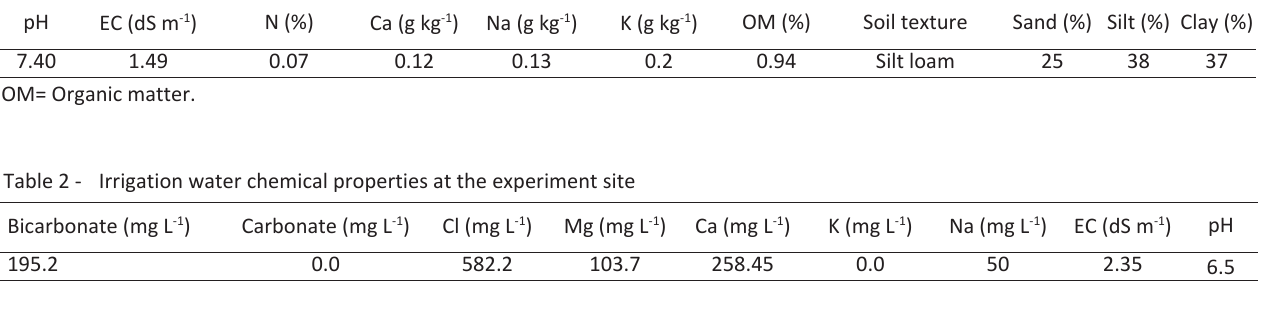
Table 1 - Soil physical and chemical properties at the experiment site